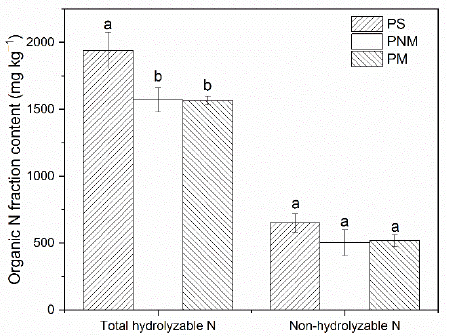
Figure 1. The content of total hydrolyzable N and nonhydrolyzable N in soils for the paddy field, P. plantation without mulching and P. plantation with mulching sites. PS, rice paddy soil; PNM, Phyllostachys praecox plantation without mulching; PM, P. praecox plantation with mulching. Bars are the mean ± standard error ( n = 3). Different lower-case letters indicate significant differences according to Duncan’s test at the 0.05 level.